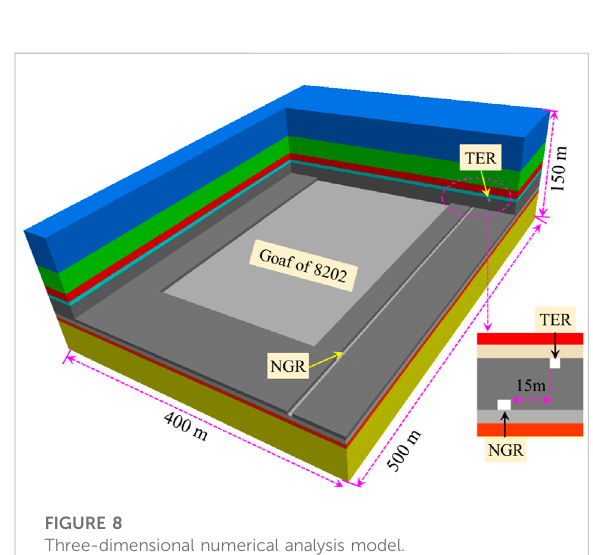
FIGURE 8 Three-dimensional numerical analysis